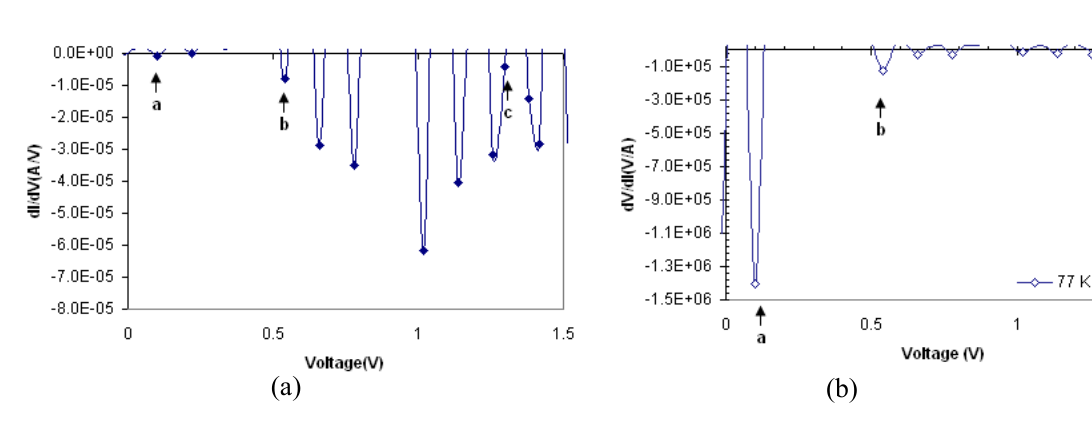
Figure 7. Differential conductance curve (dI/dV) as a function of voltage at 77 K (left figure). Differential resistance curve as a function of voltage at 77 K (right figure). Negative differential resistance can be seen at points a, b and c.